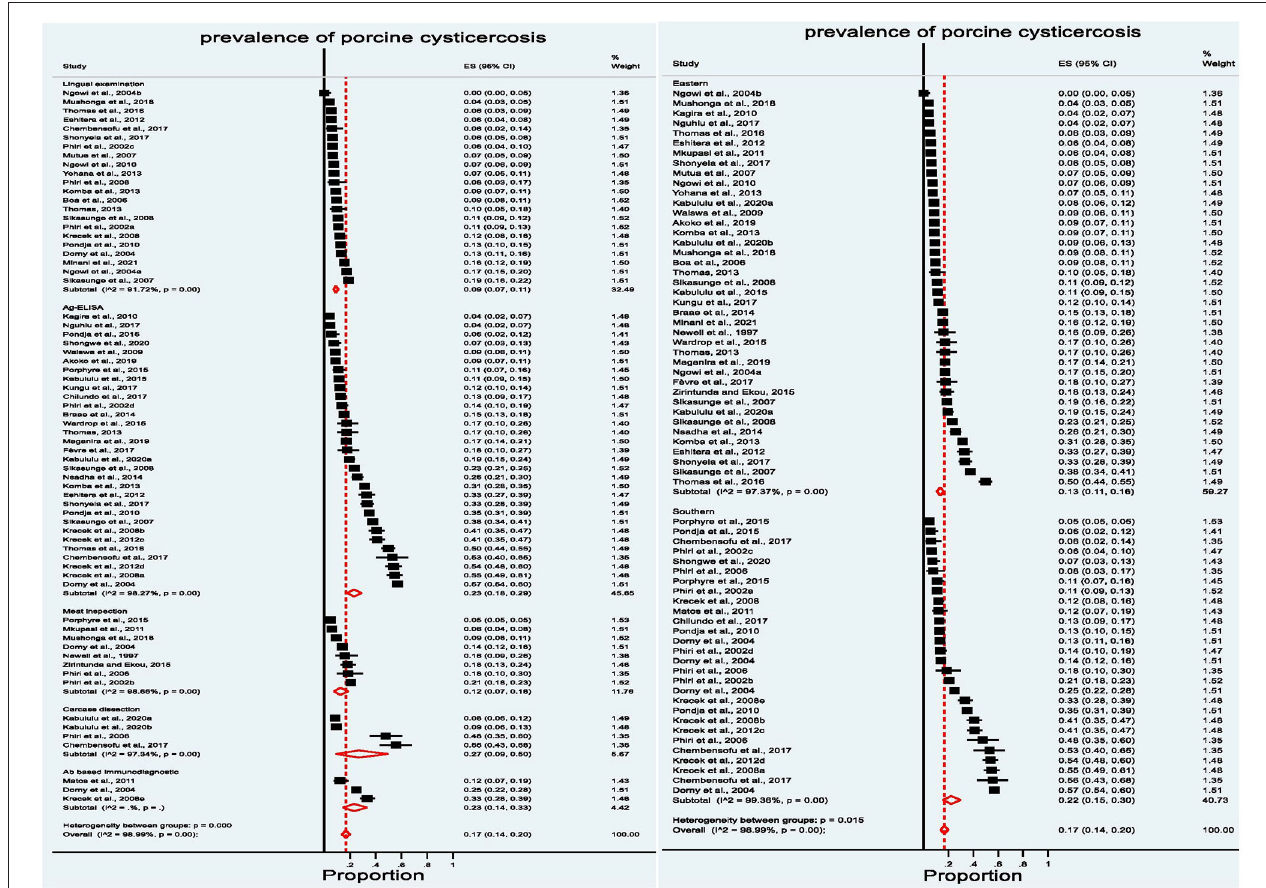
FIGURE 6 | Forest plot showing subgroup analysis of prevalence reports grouped by the diagnostic technique (left) and region (right)